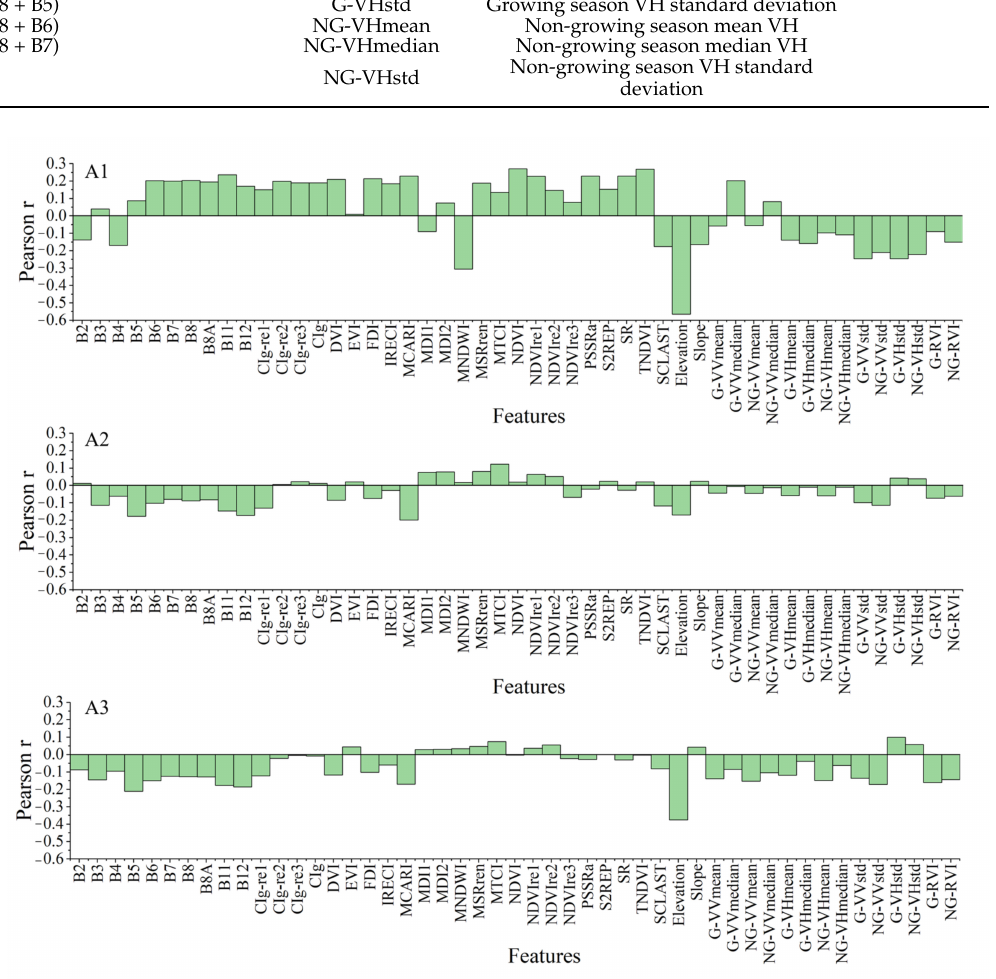
Figure A1. Correlations between canopy height and features derived from ancillary images in BART ( A1 ), HARV ( A2 ), and HOPB ( A3 ). Explanations of each feature can be found in Table